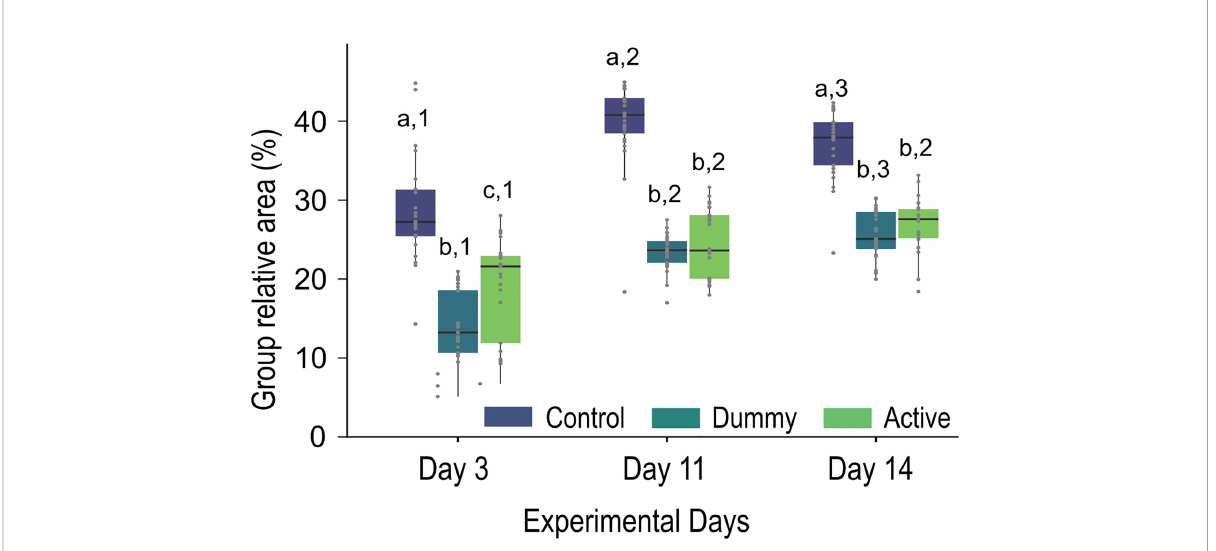
FIGURE 5 Boxplots showing the group cohesion expressed as the relative area covered (in percent) by the control (N=25 fi sh), dummy (N=20 fi sh), and active group (N=24 fi sh), on the 3rd, the 11th, and the 14th day of the experiment. Black horizontal lines indicate the median values. Lower values indicate a higher cohesion. Statistically signi fi cant differences between treatments (groups) on each sampling (day) are indicated with different letters and between samplings for each treatment with different numbers.